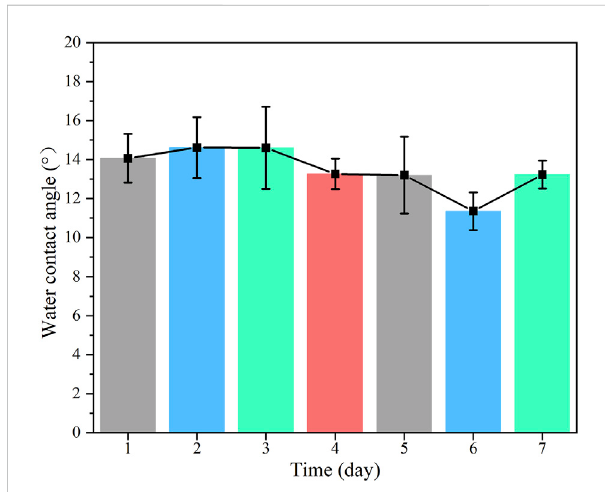
FIGURE 5 The change of water contact angle of the Ti-Cu@P(DA-co- SBMA) exposed to air for 7